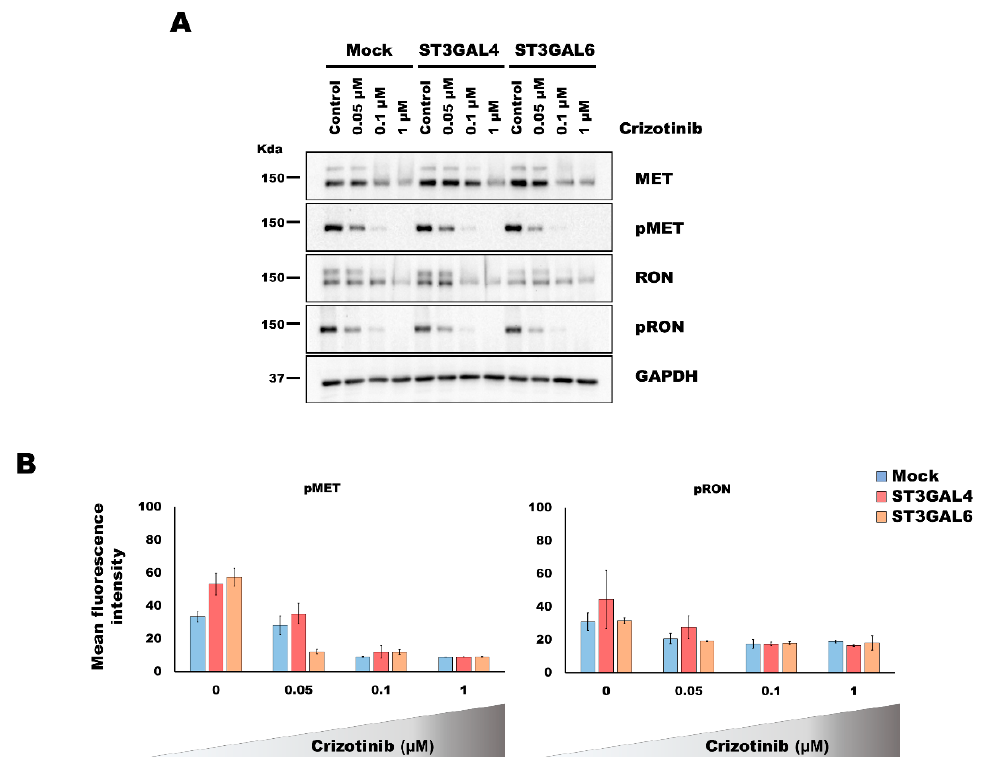
Figure 3. Evaluation of the activation of the tyrosine kinase receptors MET and Recepteur d’Origine Nantais (RON) in MKN45 gastric multicellular tumor spheroids (MCTS) overexpressing α 2,3-sialylation after crizotinib treatment. Gastric MCTS were generated using the 3D Petri Dish ® technology (MICROTISSUES ® ) for 5 days and treated with di ff erent concentrations of crizotinib for 48 h. ( A ) Western blot analysis of MET and RON receptor tyrosine kinases and their activated forms, pMET and pRON. GAPDH was used as a loading control. ( B ) Results of the automated image analysis of the immunofluorescence staining of gastric MCTS (Supplementary Material Figure S1) subjected to di ff erent concentrations of crizotinb. No significant di ff erences were found (Student’s t -test, p -value > 0.05).